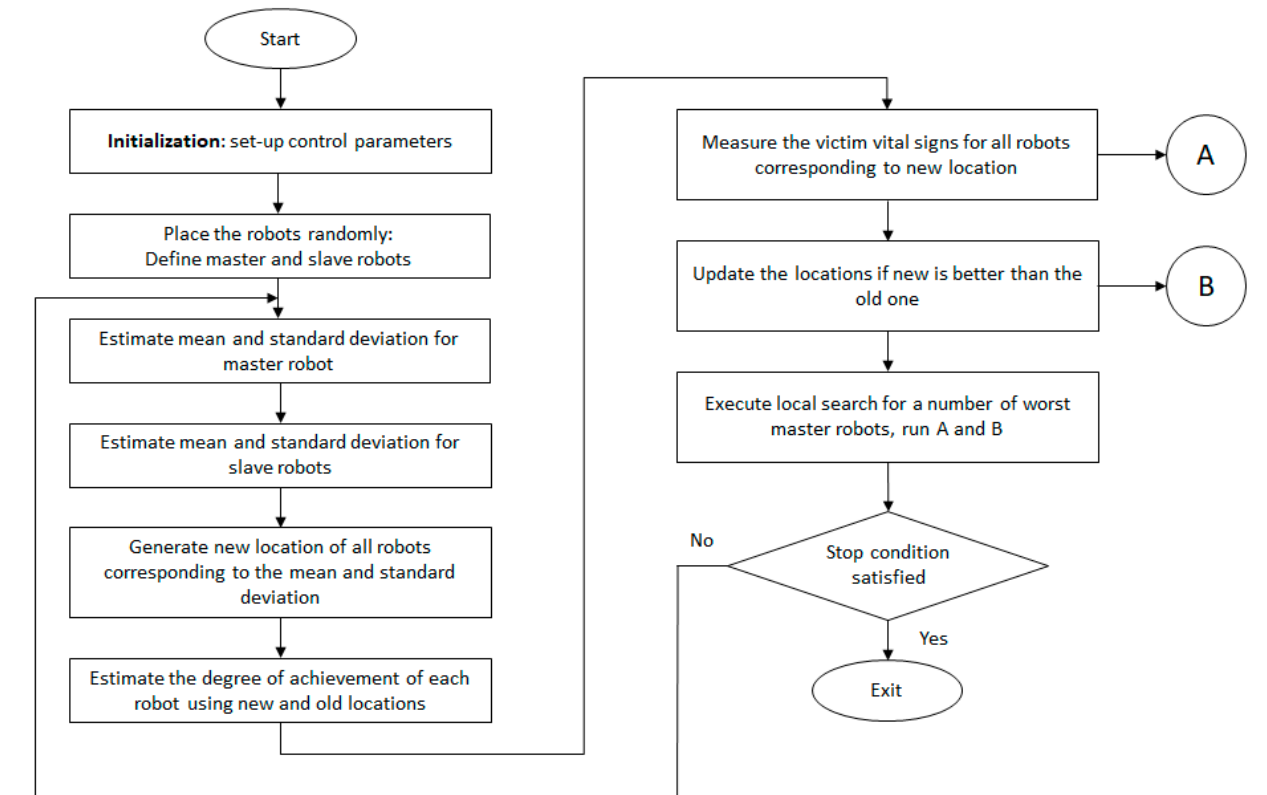
Figure 10. Flowchart of SRSR Algorithm.